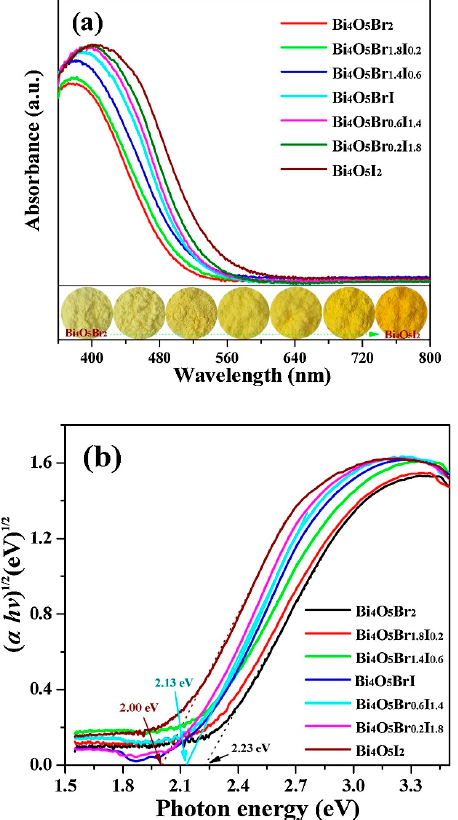
Figure 8. ( a ) Diffuse reflectance spectroscopy (DRS) spectra of Bi 4 O 5 Br x I 2 − x, Bi 4 O 5 I 2 and Bi 4 O 5 Br 2 , ( b ) Graph of ( α hv ) 1/2 vs. ( hv ) [116] Copyright Elsevier 2018.